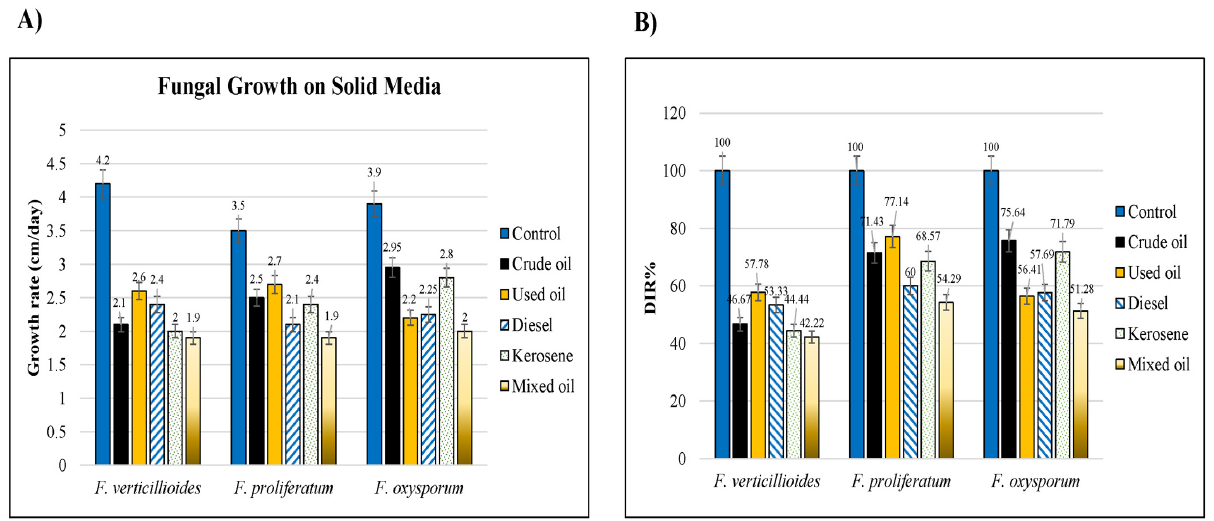
Figure 2. Charts showed the hydrocarbons tolerance of three Fusarium species growing on MSM solid medium with 1% of the studied hydrocarbons versus the control (water). ( A ) growth rate expressed in cm/day, ( B ) DIR percentages at 1% concentrations.